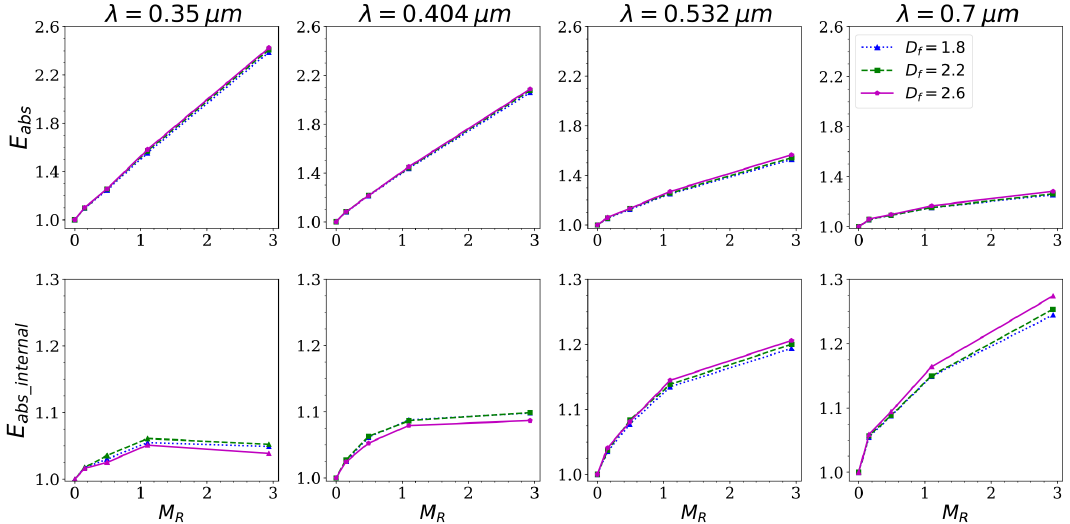
Figure 8. E abs and E abs_internal of thinly coated BC with BrC coatings varying with M R for different D f values ( r g = 0 . 06µm, σ g = 1 .